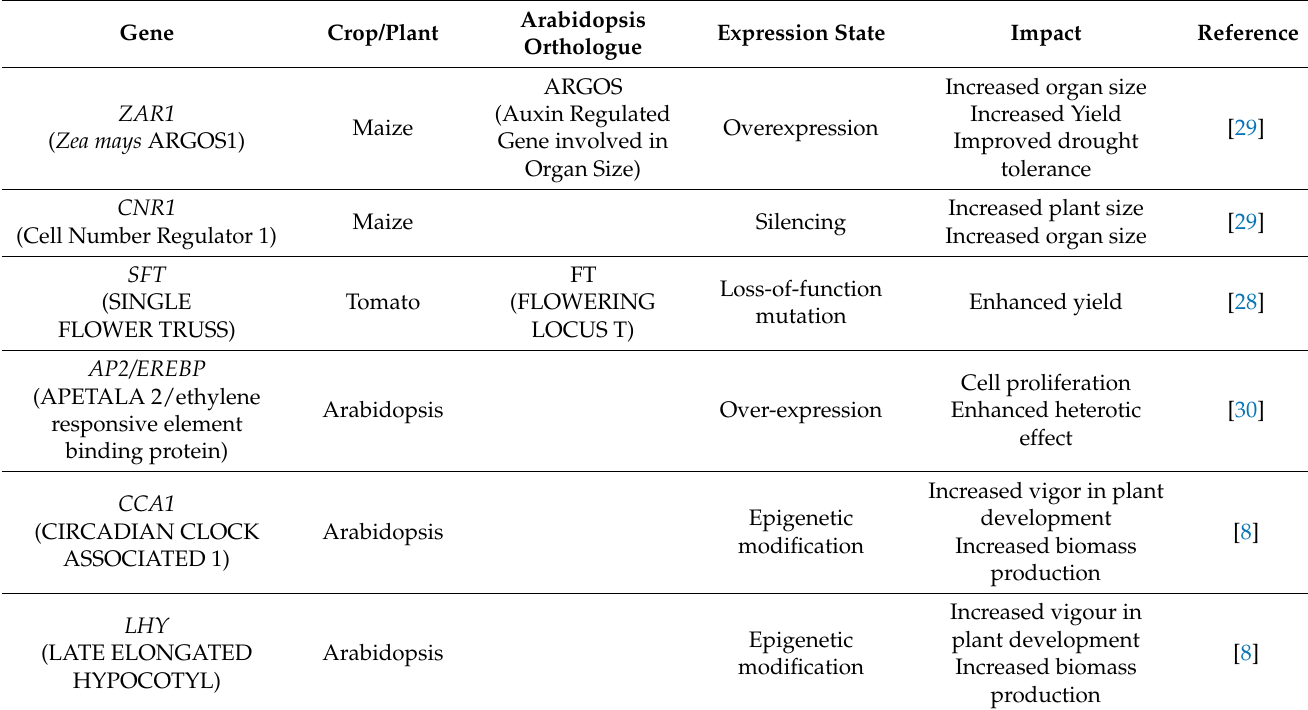
Table 1. List of genes and their expression associated with various genetic traits contributing to heterotic effect in different plant